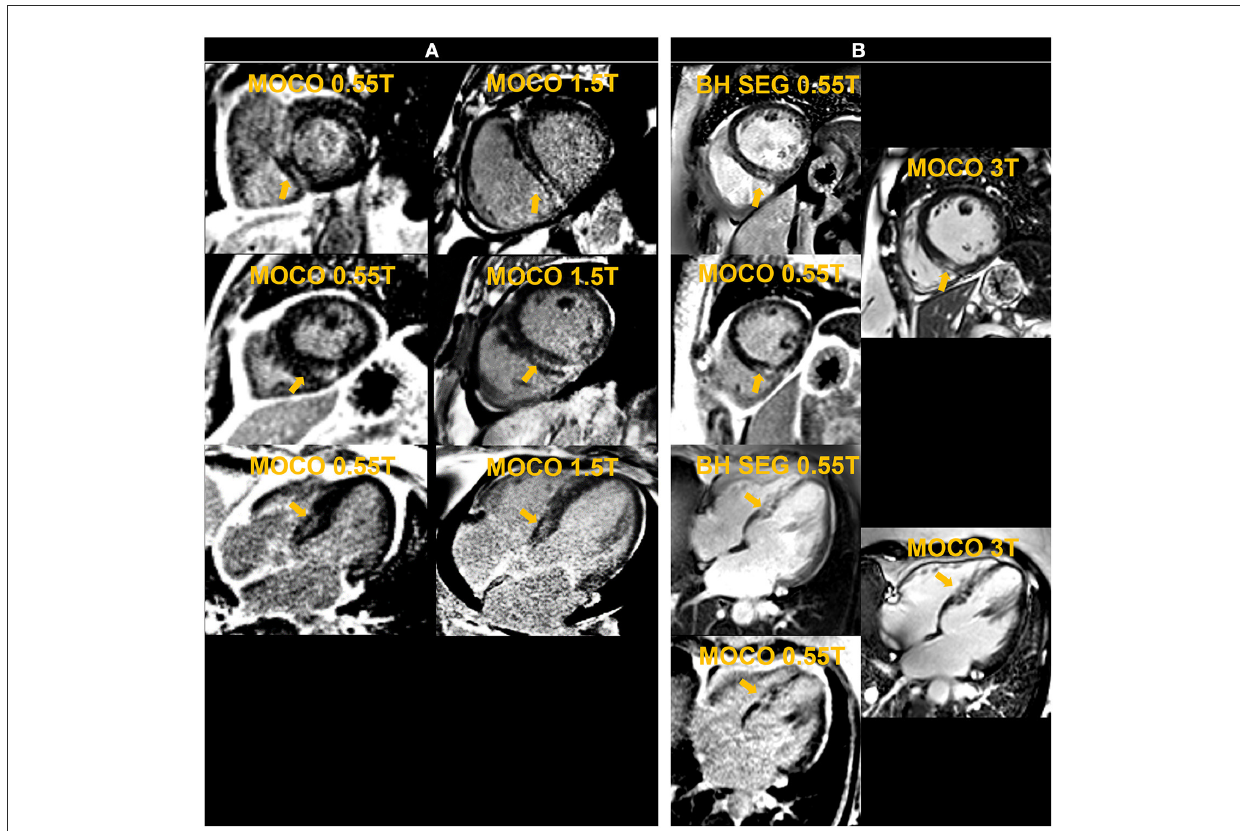
FIGURE8 The left panel shows motion-corrected and averaged free-breathing single-shot late gadolinium enhancement images (MOCO LGE) in a patient [Patient (A) ] demonstrating mid-wall non-ischemic fibrosis pattern at 0.55T and 1.5T. The right panel shows breath-held (BH) segmented (SEG) and MOCO LGE images acquired at 0.55T in comparison to corresponding MOCO LGE images at 3T in another individual [Patient (B) ] and demonstrates infarct scar at the inferior septum.